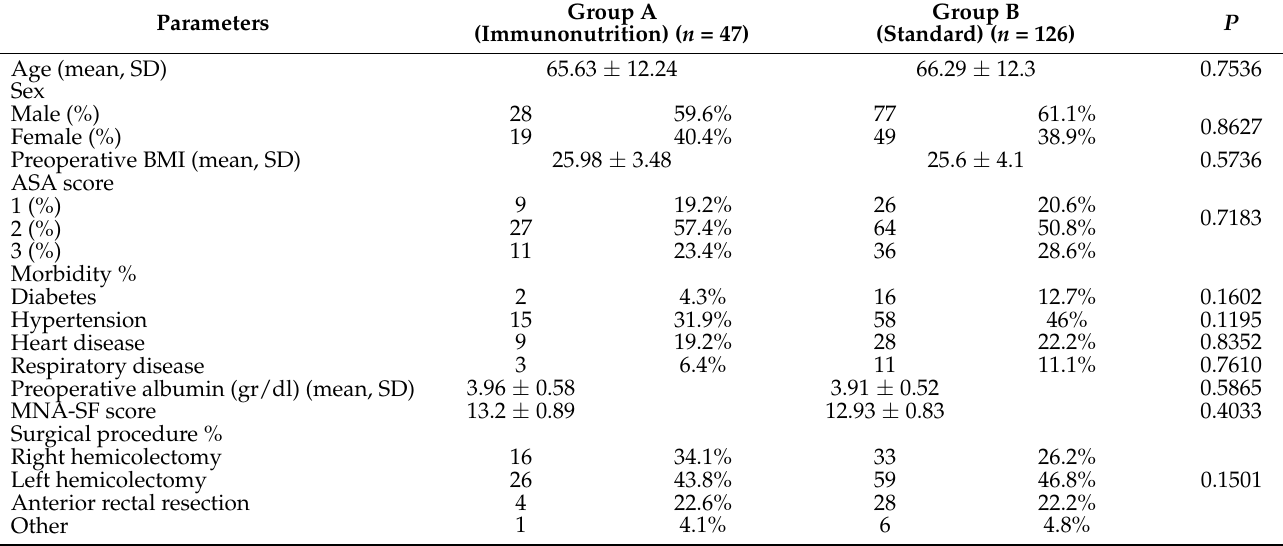
Table 3. Results of preliminary